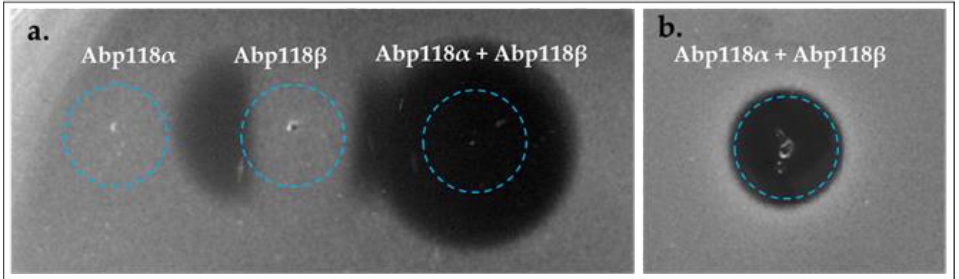
Figure 4. Antimicrobial activity of the IV-CFPS-produced Abp118α and Abp118β bacteriocins, alone or together, by using the spot-on-lawn test (SOLT) against P. damnosus CECT 4797 ( a ) and L. salivarius P1ACE3 ( b ), as the indicator organisms. The blue circle indicates the position and area occupied by each of the fractions tested.